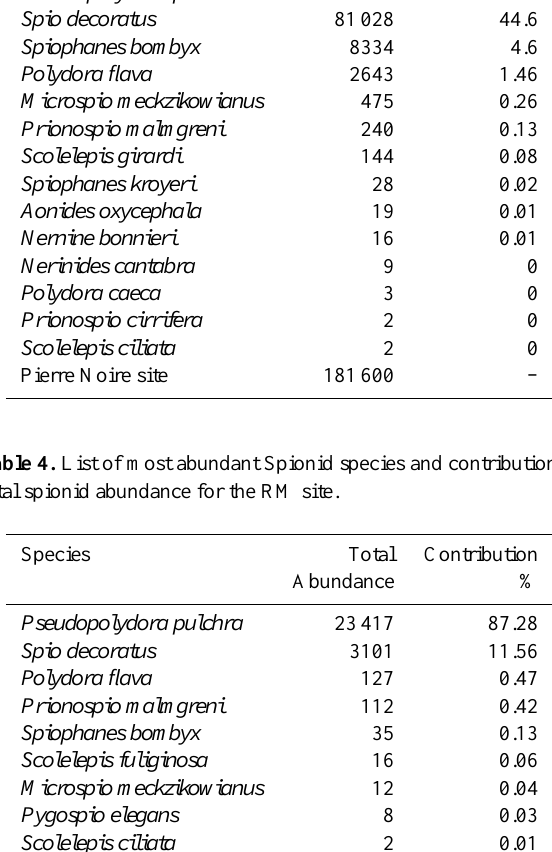
Table 1. List of most abundant species and contribution to total abundance for the PN site.